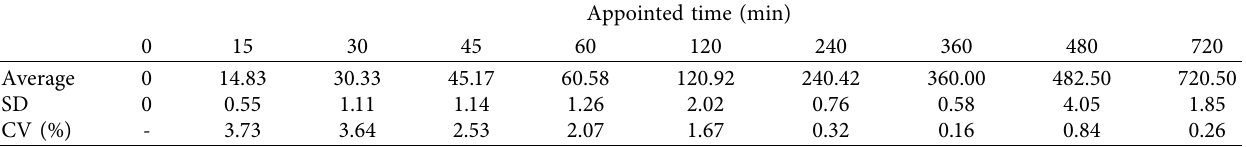
Table 1: Comparison of the actual blood collection time and the appointed blood collection time in six mice. Appointed time (min)